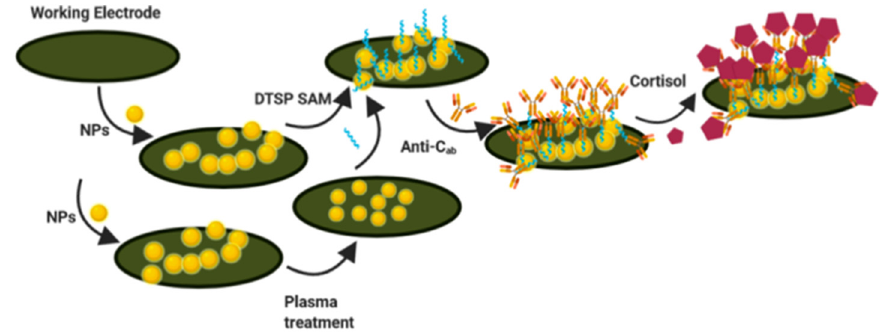
Figure 15. Steps in the fabrication of a cortisol immunosensor on untreated (drop-cast) and AuNP- modified plasma-treated electrodes (reproduced with permission from [75]. Copyright 2021 American Chemical Society).